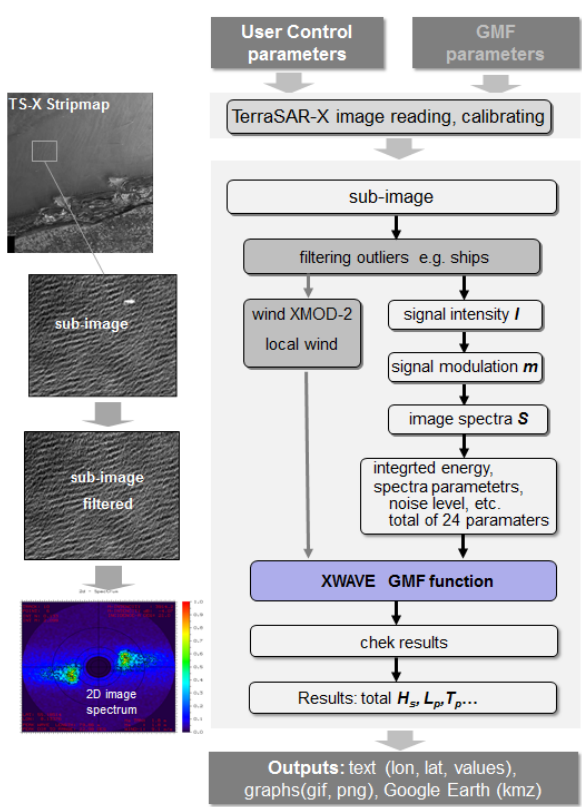
Figure 3. Flow chart of Sea Sate Processor (SSP). The XWAVE algorithm Eq.2 has been repeatedly validated and adapted for coastal sea state in order to improve the existing function. In the first instance the CWAM model data were used for spatial-temporal validation in order to understand the source of outliers and create the additional terms necessary to compensate perturbations. Model data served thus only to establish an appropriate ansatz function, that is capable of representing all spectrally significant phenomena. Although the model reproduces the spatial distribution of sea sate correctly, the model scatter index for buoy positions and TS-X images date is SI HsCWAM/BOUY =0.23 and the values are sometimes overestimated by 0.5-1.0m (total mean value of H S =1.5m for buoy locations with mean value of 2.5m for storm conditions).